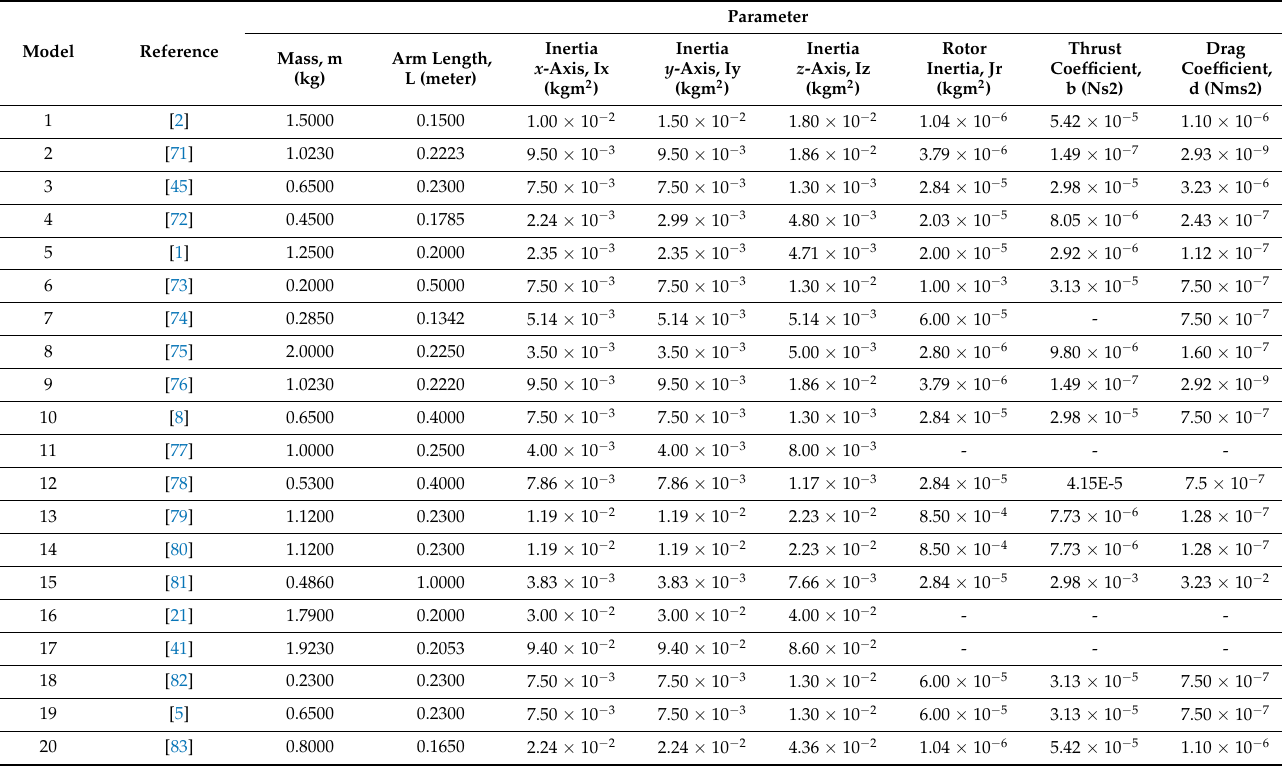
Table 1. Parameters of the